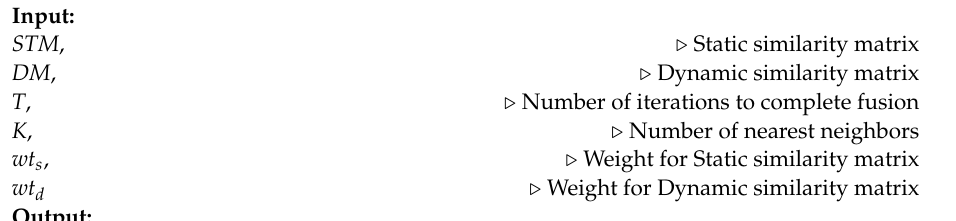
Algorithm 3. Similarity network fusion